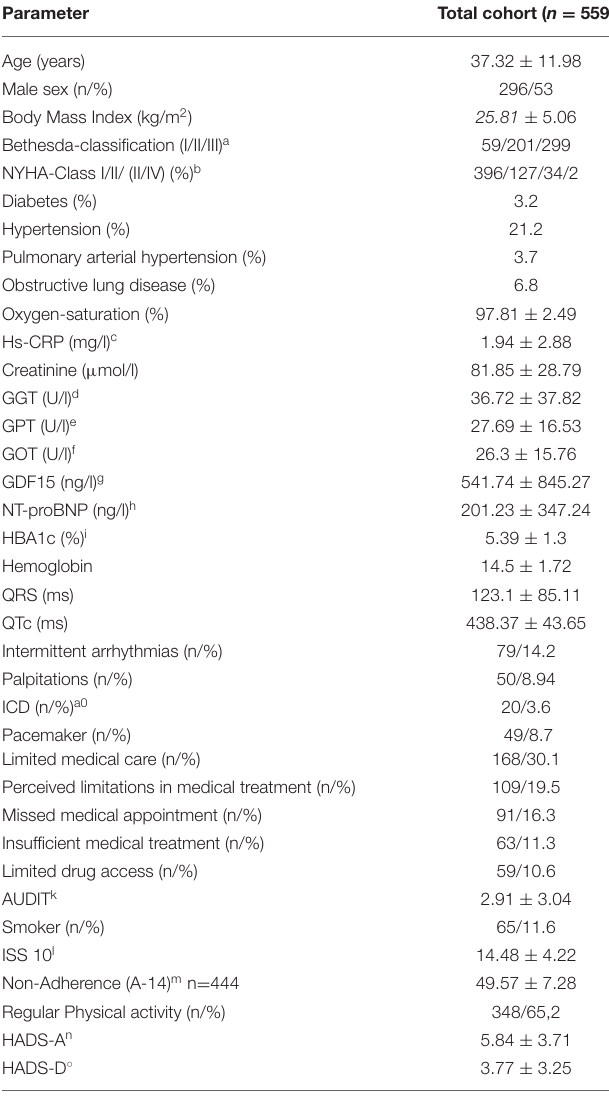
TABLE 1 | Demographic, psychiatric, lifestyle and clinical characteristics of total cohort.